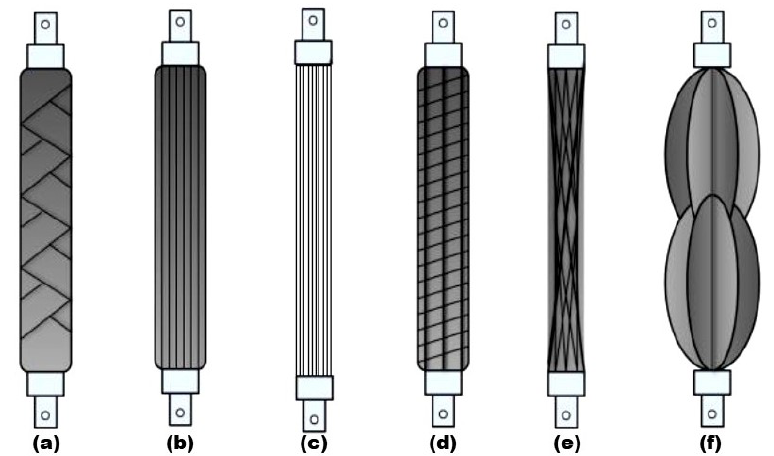
Figure 1. Types of conventional PAMs [6]:( a ) McKibben Muscle/Braided Muscle; ( b ) Pleated Muscle; ( c ) PAM reinforced by Kevlar Fiber; ( d ) Yarlott Netted Muscle; ( e ) Paynter Hyperboloid Muscle; ( f ) ROMAC Muscle.